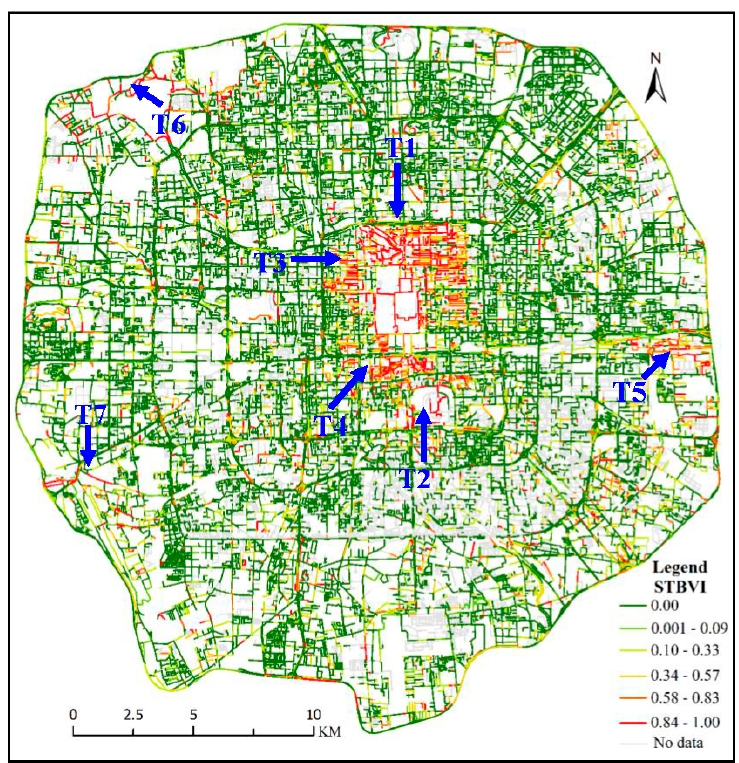
Figure 9. The overall spatial distribution of the street of traditional building view index (STBVI) of the Chinese traditional-style buildings.